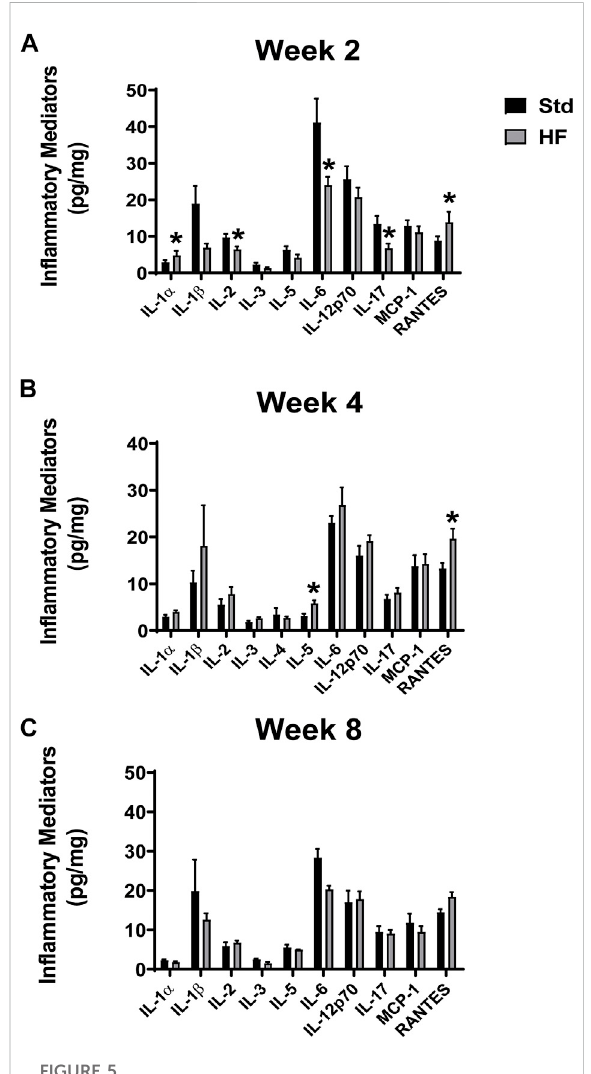
FIGURE 5 In fl ammatory Mediators in the Lumbar DRG. Std vs HF after 2 weeks (A) , 4 weeks (B) , and 8 weeks (C) of dietary intervention. Dataarepresented asmean±SEM( n =3 – 12micepergroup).* p < 0.05 vs for Std vs HF. IL-10, IFN- γ , TNF- α , MIP-1a, GMCSF were below the limits of detection in the majority of the samples, thus means could not be calculated.